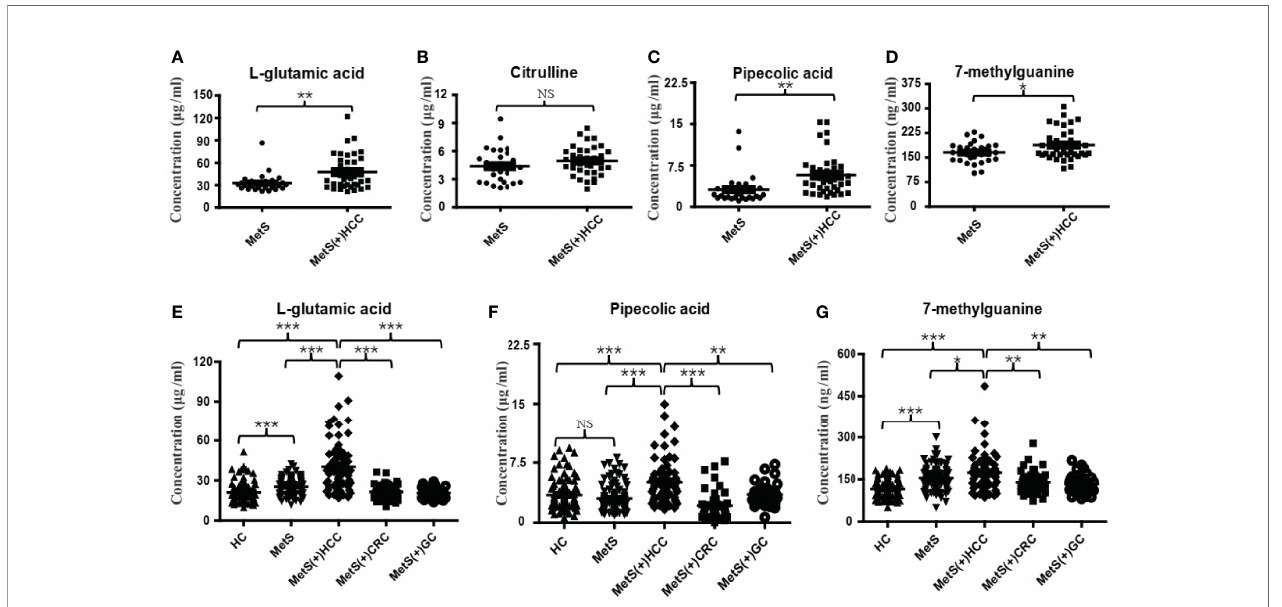
FIGURE 3 | Expression pro fi les of some dysregulated metabolites in the discovery and validation cohorts. (A) The levels of serum L-glu in the discovery cohort. (B) The levels of serum Citru in the discovery cohort. (C) The levels of serum PA in the discovery cohort. (D) The levels of serum 7-mG in the discovery cohort. (E) The levels of serum L-glu in the validation cohort. (F) The levels of serum PA in the validation cohort. (G) The levels of serum 7-mG in the validation cohort. NS, not signi fi cant. *p value < 0.05; **p value < 0.01; ***p value < 0.001.